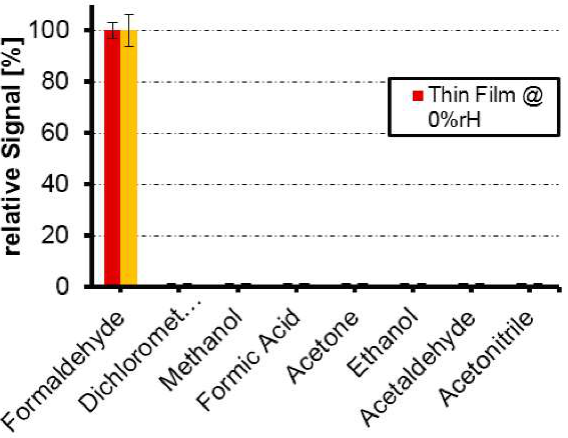
Figure 11. Formaldehyde sensor produced by Hussain et al. with several gases at 100 ppm. The graph is striking but somewhat superfluous as it simply shows formaldehyde at 100% and all other VOCs at 0%. MIP films (red) and nanoparticles (yellow) were prepared using an approximately 1:1:1:2 template-monomer-monomer-crosslinker ratio in methanol and dimethylformamide. Films were spin-coated directly onto the QCM electrode, while nanoparticles were first precipitated by addition of acetonitrile. Reproduced with permission [21].